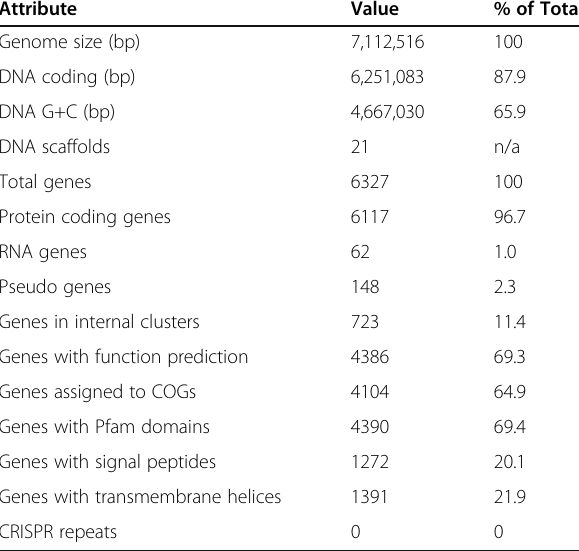
Table 1 Genomic feature of Delftia sp. K82